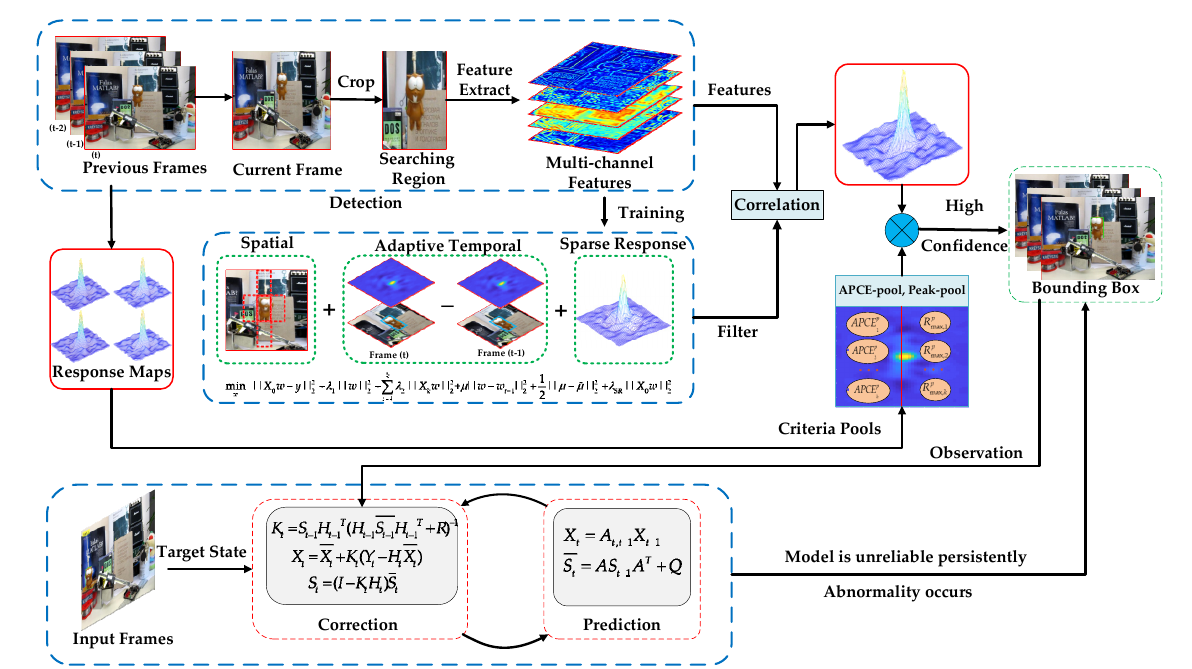
Figure 1. Flow chart of the Ad_SASTCA